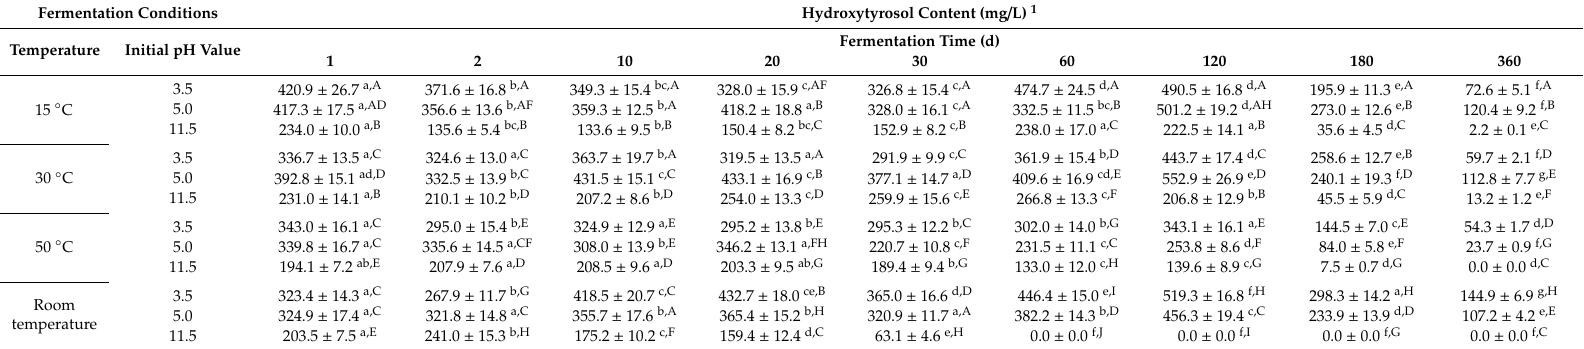
Table 4. Changes in hydroxytyrosol content during the spontaneous fermentation of Spanish-style green olive processing wastewaters under di ff erent temperature and initial pH